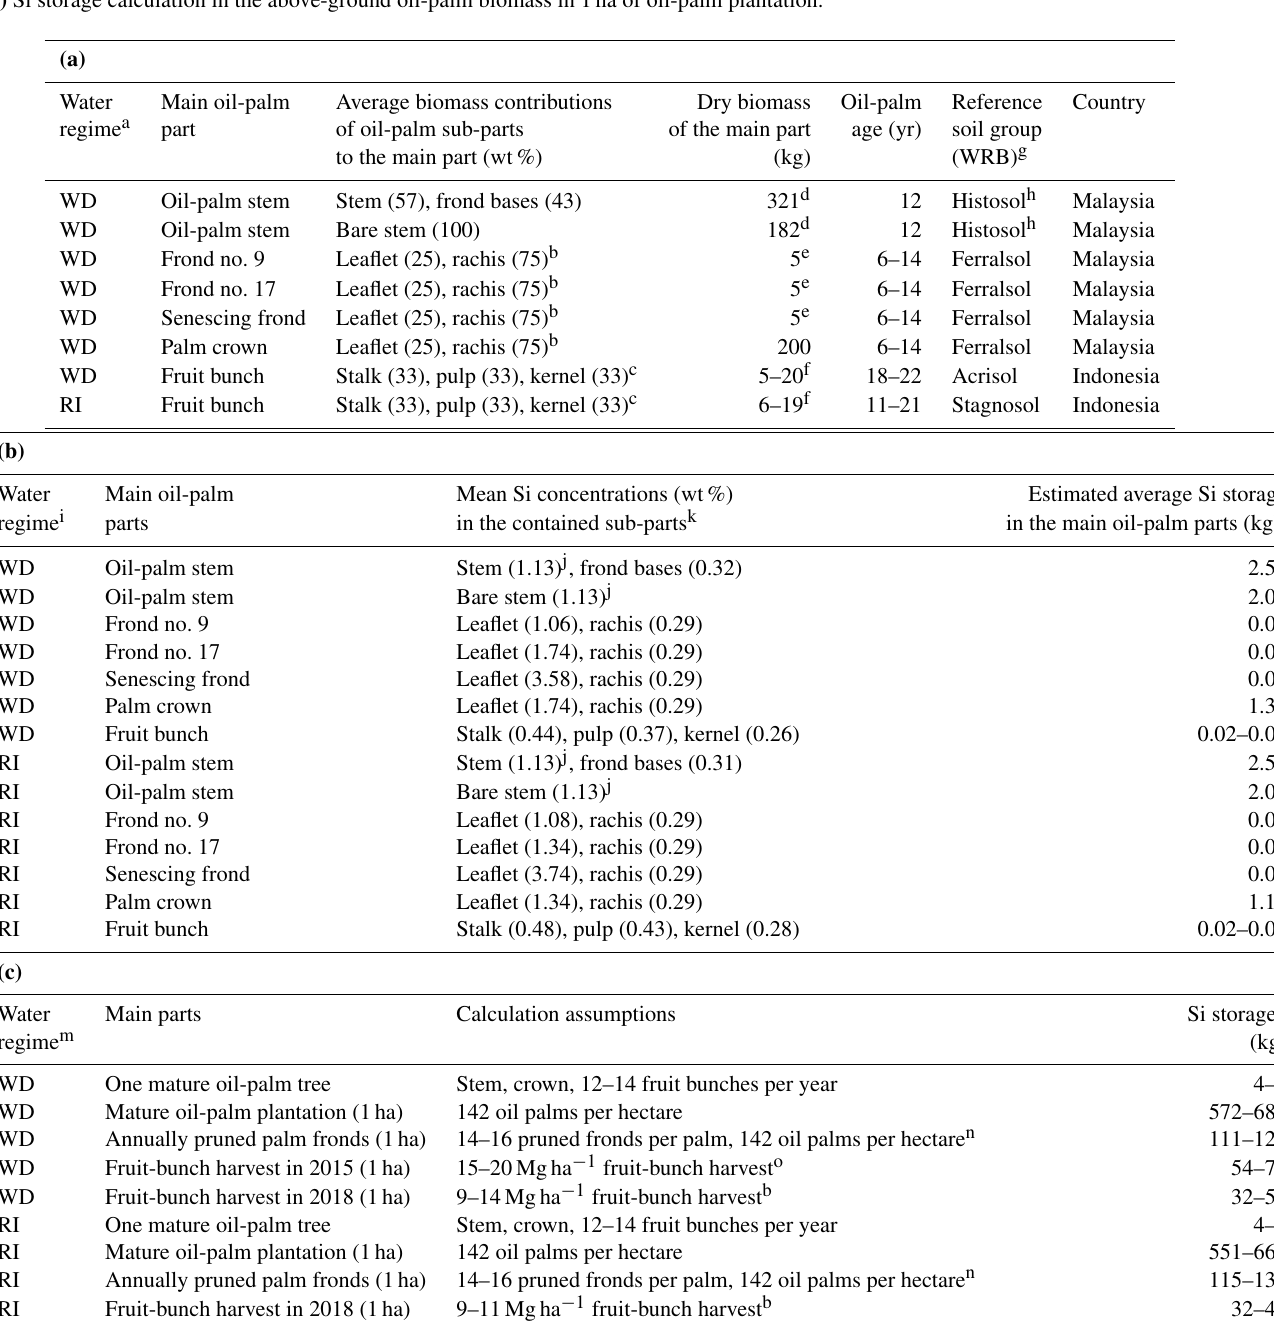
Table 2. (a) Dry biomass estimates of the main parts of mature oil palms in South-East Asia and relative contributions of oil-palm sub-parts to the biomass of the main parts. (b) Calculation of average Si storage in the main oil-palm parts of mature oil palms in South-East